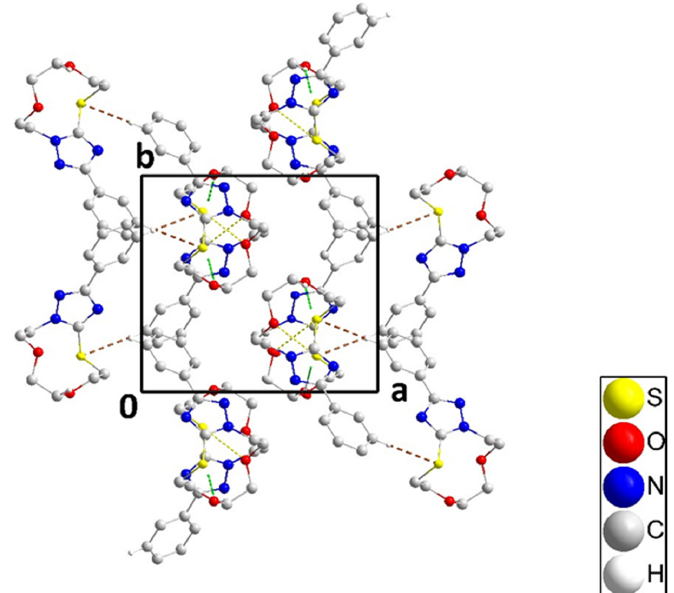
Figure 3. Perspective view of 3 with the labeling scheme and 50% probability ellipsoids ( left ). A portion of one chain of molecules viewed along the a -axis direction with C–H ⋅⋅⋅ π (ring) and O ⋅⋅⋅ S interactions depicted, respectively, by green and yellow dashed lines. Non-interacting hydrogen atoms are omitted for clarity ( right ).